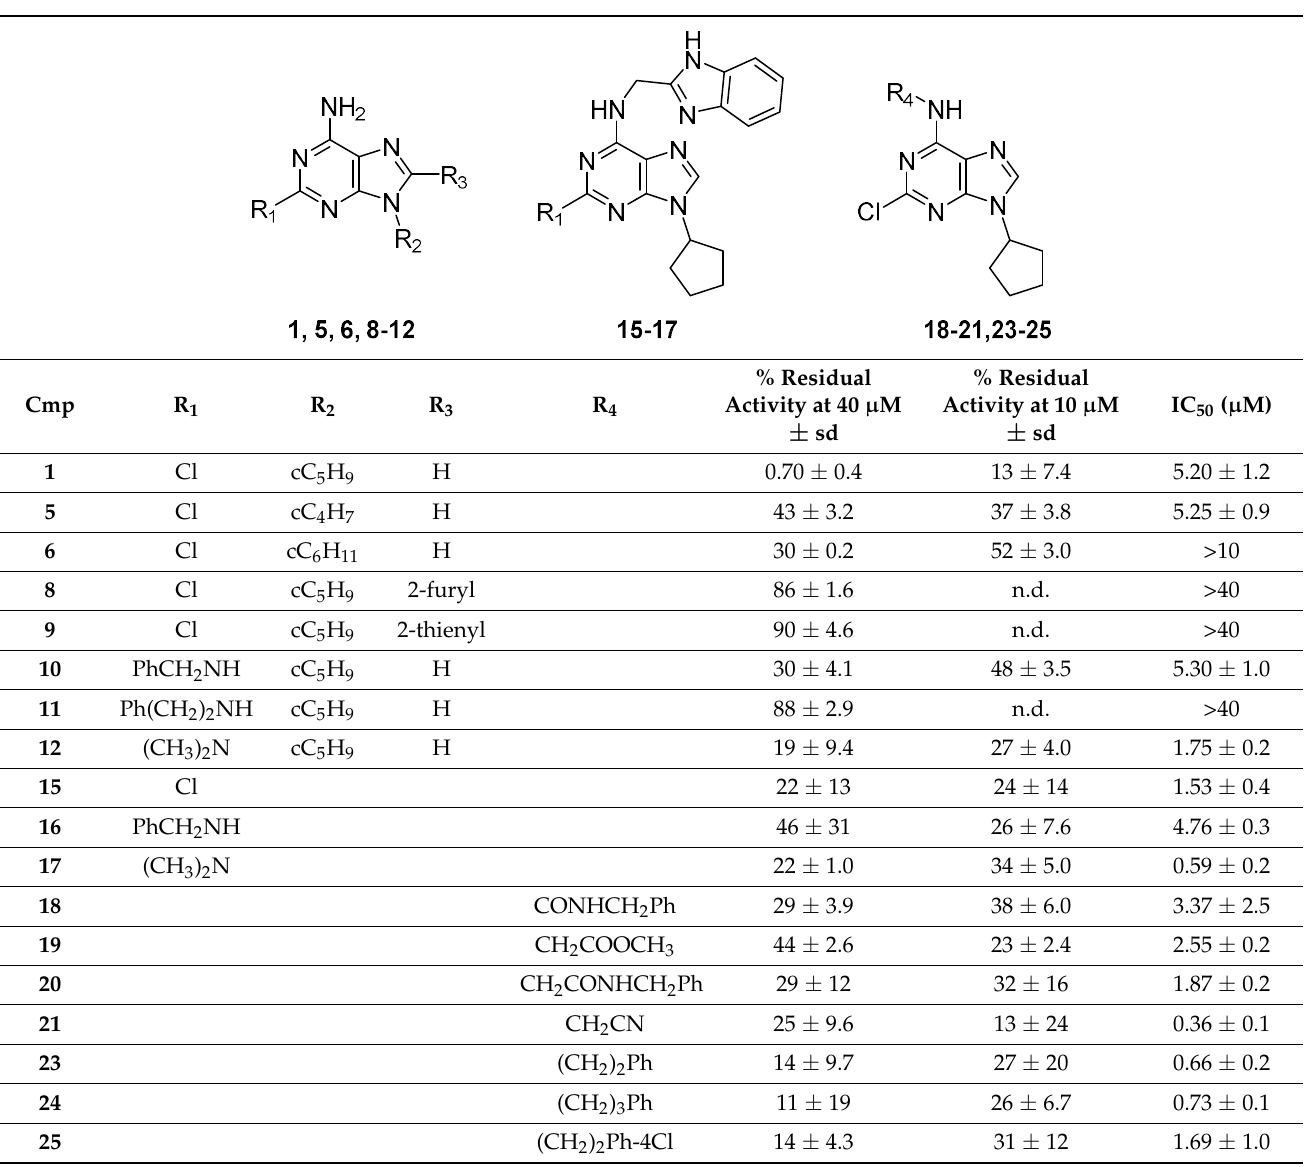
Table 1. Enzymatic inhibition activity of compounds 1 , 5 , 6 , 8 – 12 , 15 – 21 , 23 – 25 tested at 40 and 10 µ M (IC 50 , μM